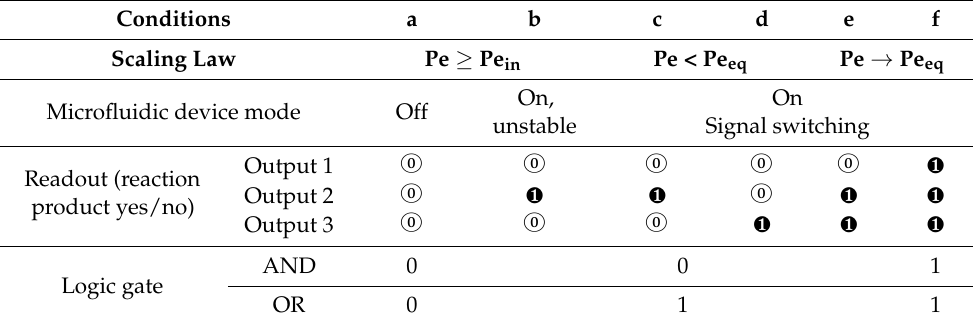
Table 2. Digital readouts and microfluidic chip states at various values of Peclet number. Conditions